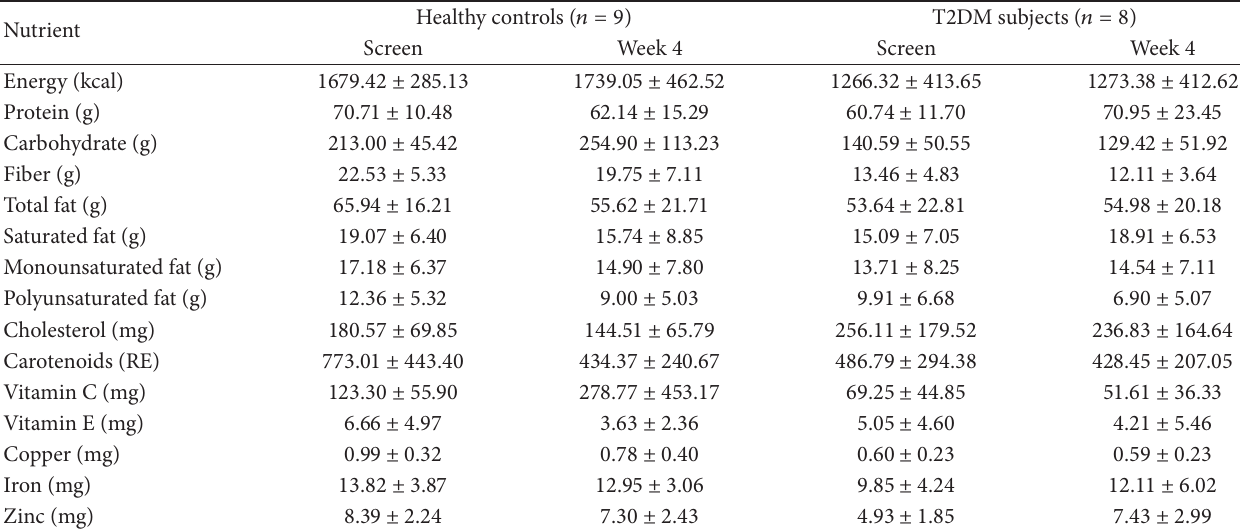
Table 5: Dietary intakes 1,2 .